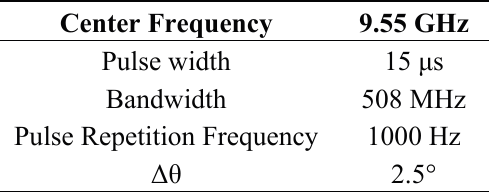
Table 4. Radar Parameters.